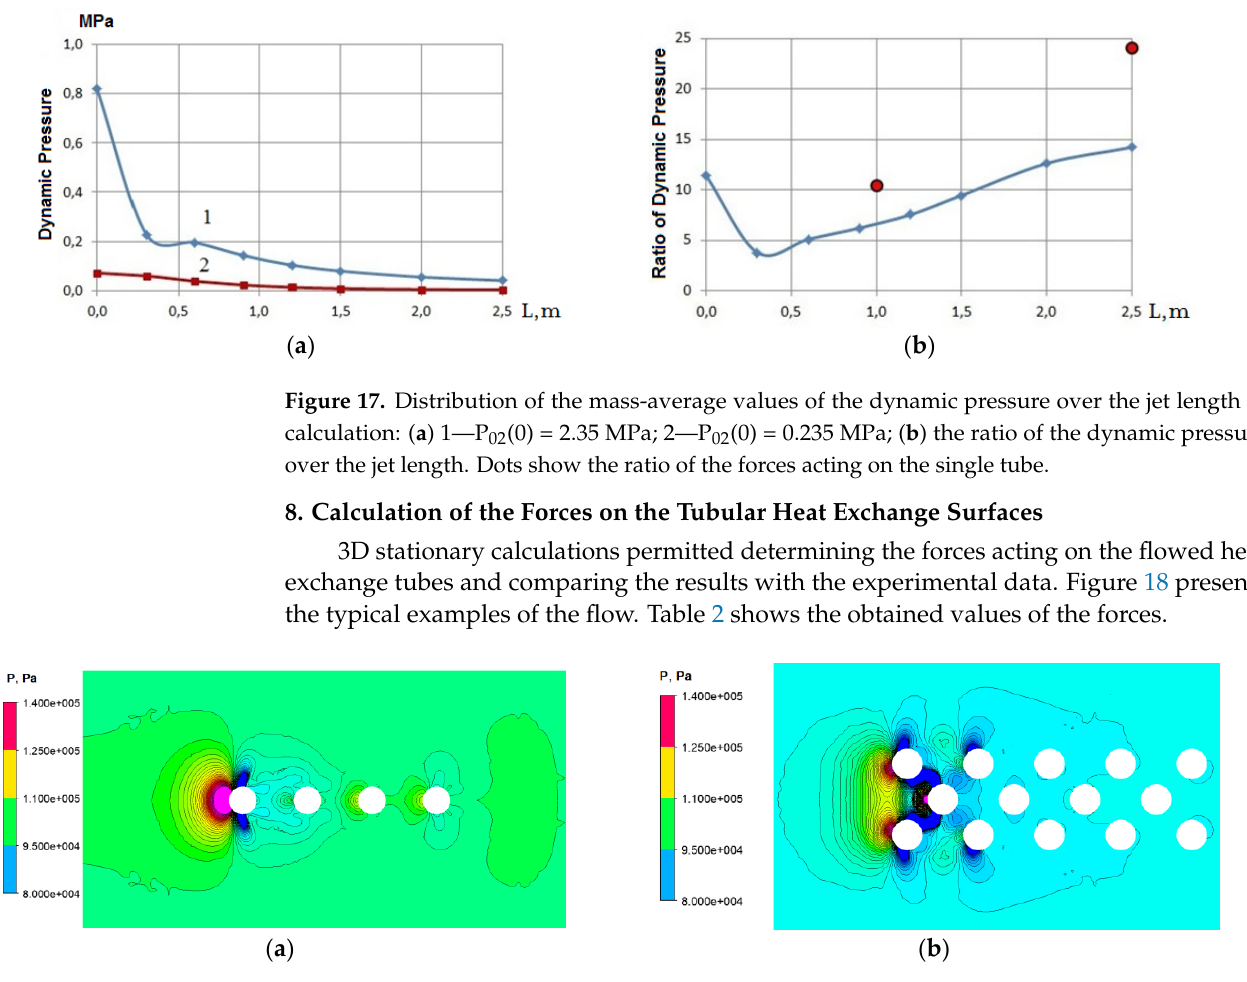
Figure 18. Pressure distribution for Р 02 (0) = 0.235 MPa at the nozzle cut: ( a ) lengthwise tube configuration; ( b ) checkerboard tube configuration. Table 2. Forces acting on the heat exchange tubes [H].